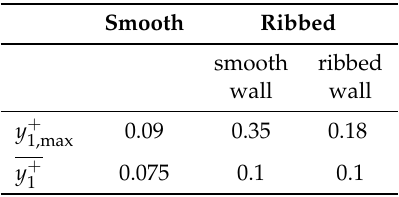
Table 1. Averaged and maximum y +